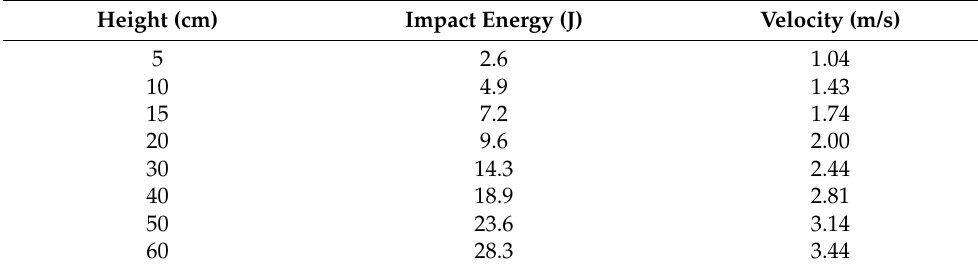
Table 4. Height, energy, and velocity of the experimental impact events.